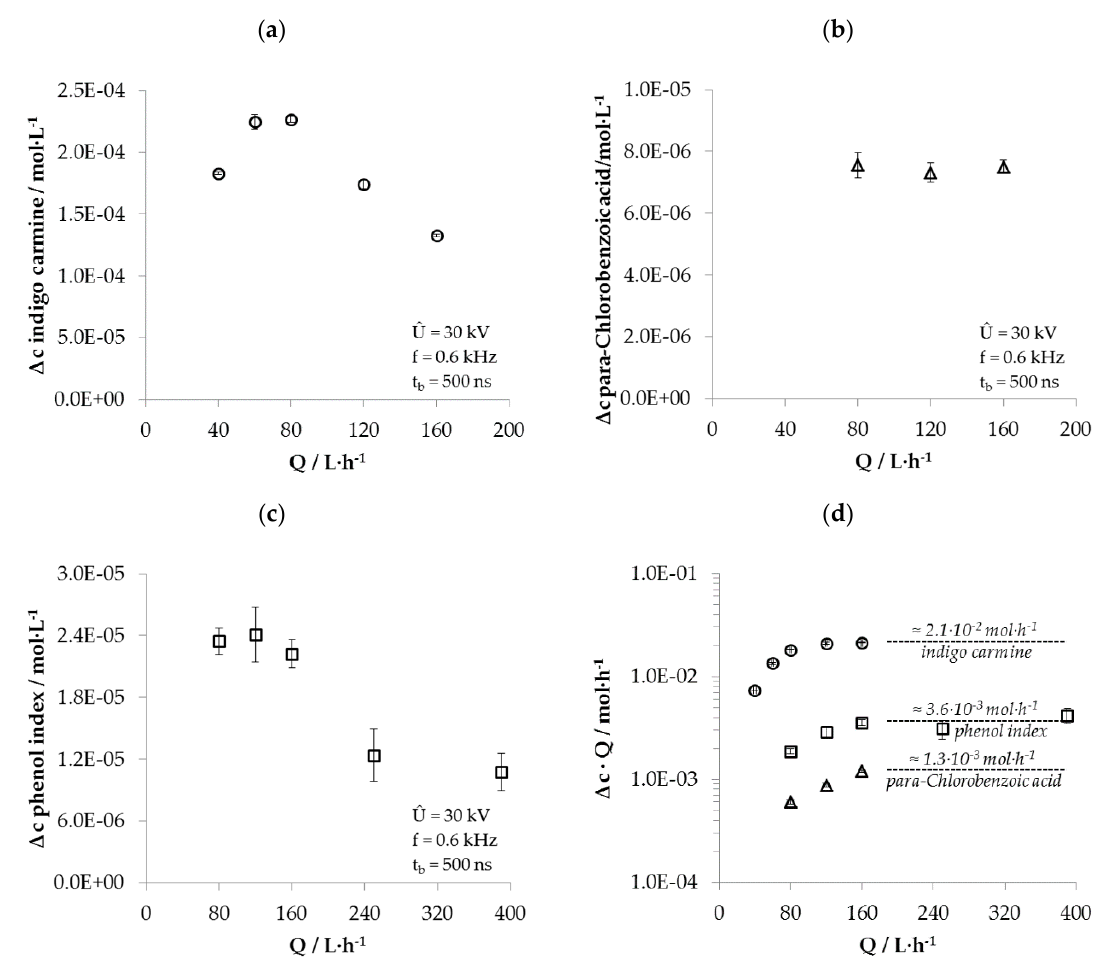
Figure 9. Decrease of ( a ) indigo carmine, ( b ) para-Chlorobenzoic acid, and ( c ) phenol index concentration ( Δ c ) depending on the volume flow rate Q , and ( d ) the molar degradation of the substances per hour depending on the volume flow rate Q .